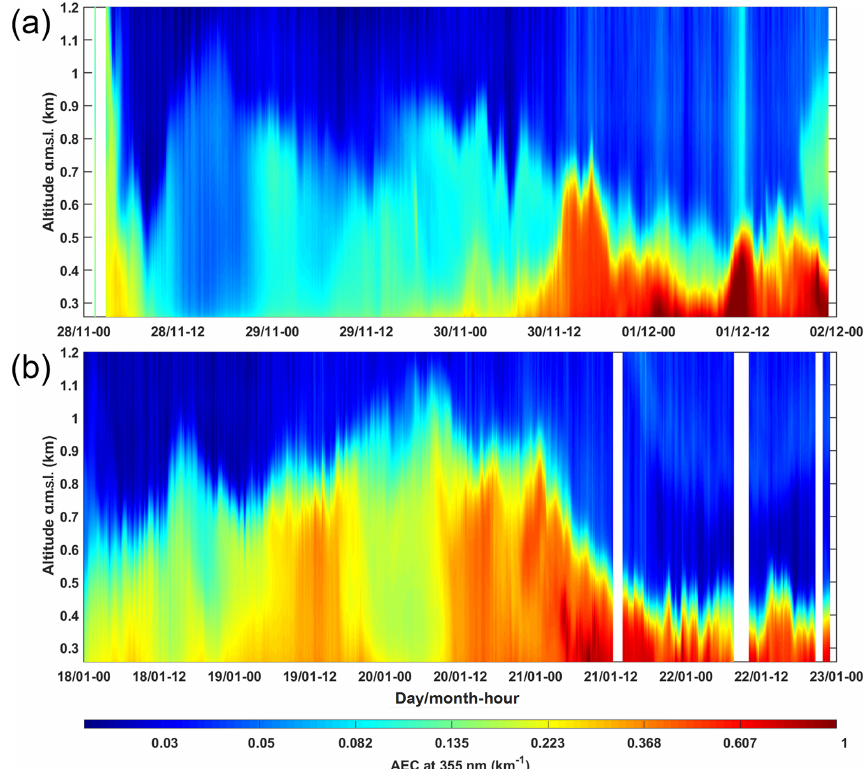
Figure 6. Temporal evolution of the aerosol extinction coefficient (AEC) at 355nm as a function of time and altitude for the two cases discussed (a) in late 2016 and (b) in January 2017. The colour set from blue to dark red shows an AEC from almost 0 to above 0.6km − 1 . White stripes correspond to the presence of